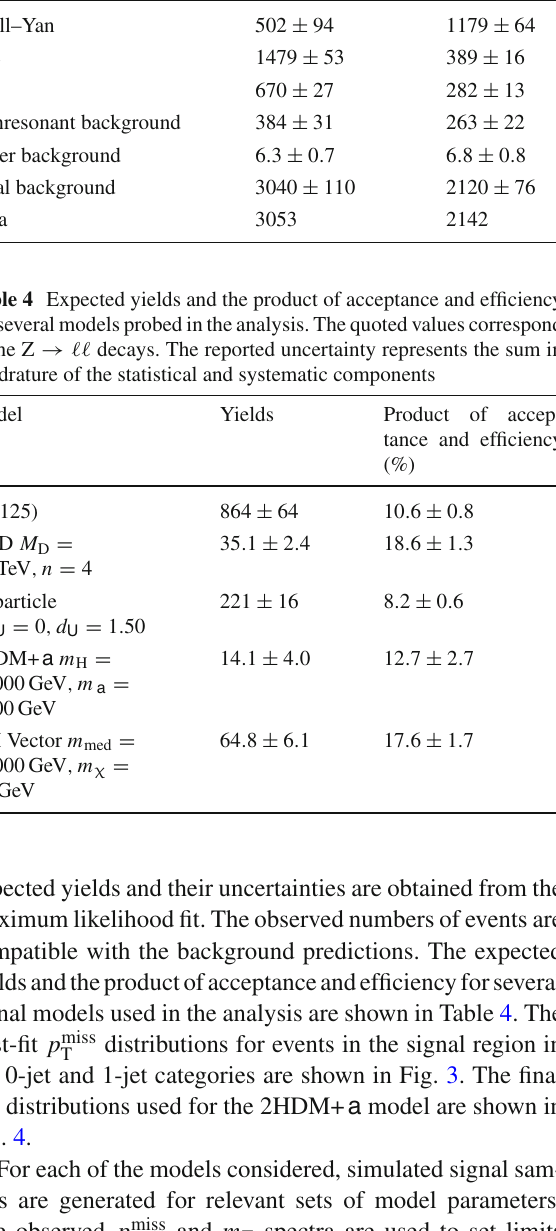
mediator as well as the coupling strengths of the mediator to distribution is used as an input quarks and to DM. The p miss T to the fit. Limits for the vector and axial-vector mediators are shown as a function of the mediator mass m med and DM parti- cle mass m χ as shown in Figure 5. Cosmological constraints on the DM abundance [92] are added to Fig. 5 where the shaded area represents the region where additional physics would be needed to describe the DM abundance. For